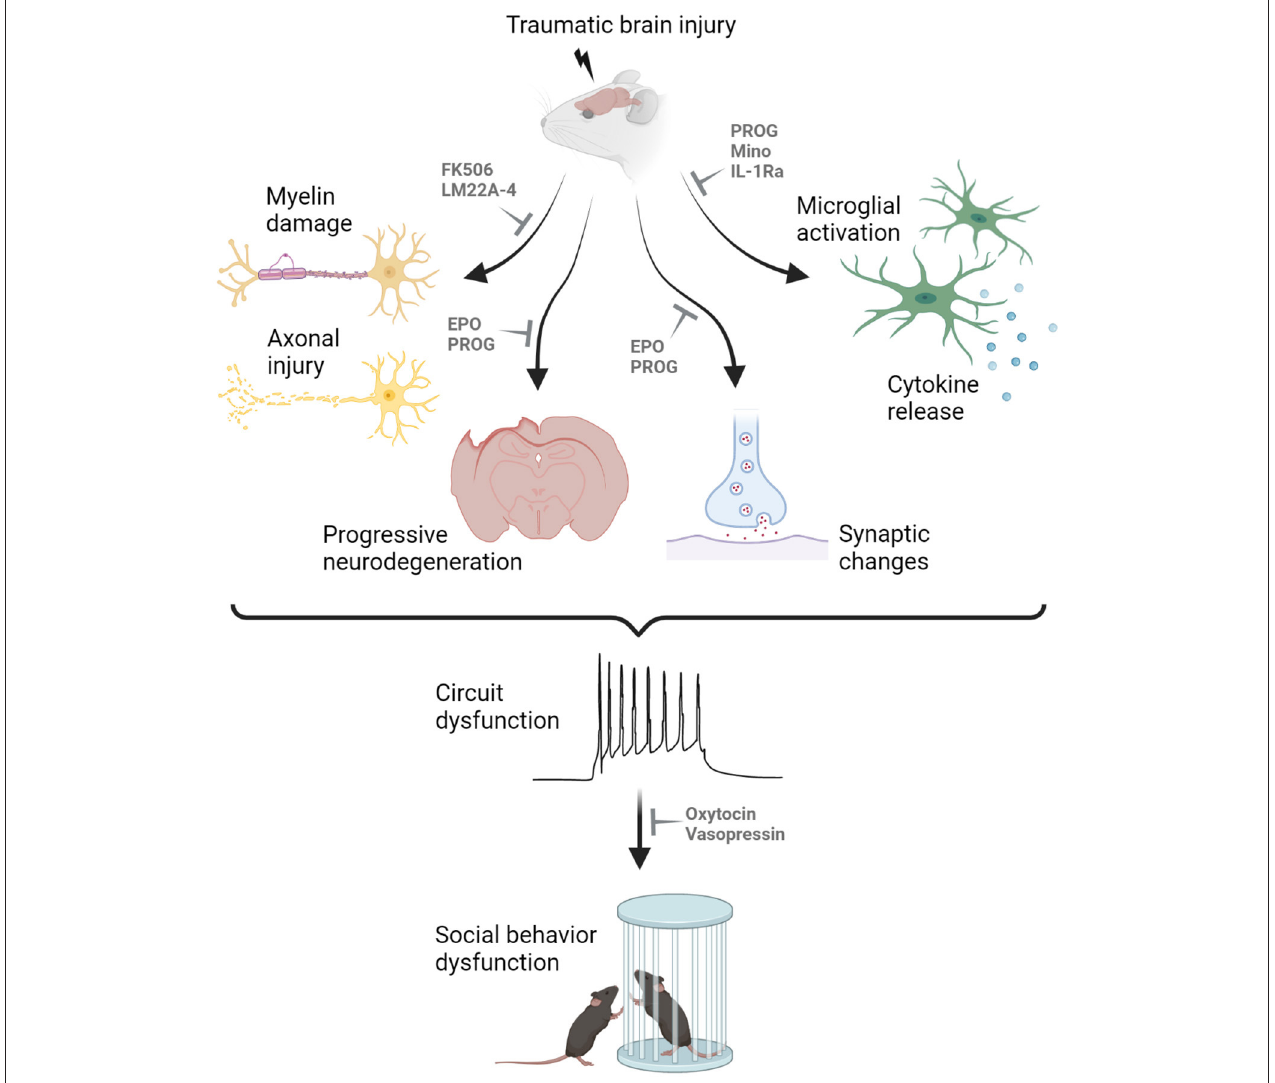
FIGURE 1 | Proposed mechanisms underlying the manifestation of social behavior deficits after pediatric traumatic brain injury (TBI). Myelin damage, axonal injury, neurodegeneration, synaptic changes, microglial activation and cytokine release all contribute to the dysfunction of neuronal circuitry underlying social cognition, resulting in abnormal social interactions in rodent models of experimental TBI. Promising drug candidates to alleviated social behavior deficits are highlighted, targeting different secondary injury processes in the pediatric injured brain. For example, FK506 and LM22A-4 have been shown to reduce demyelination and axonal injury; progesterone (PROG) and erythropoietin (EPO) can prevent neurodegeneration and aberrant synaptic changes; and several compounds including PROG, minocycline (Mino) and interleukin-1 receptor antagonist (IL-1Ra) can minimize microglial activation and cytokine release. Such therapeutic targeting may reduce the extent of secondary injury after pediatric TBI to prevent the development of social behavior deficits. In contrast, treatments such as oxytocin and vasopressin may be administered once the abnormal circuitry is already present, to promote pro-social behaviors. Created with